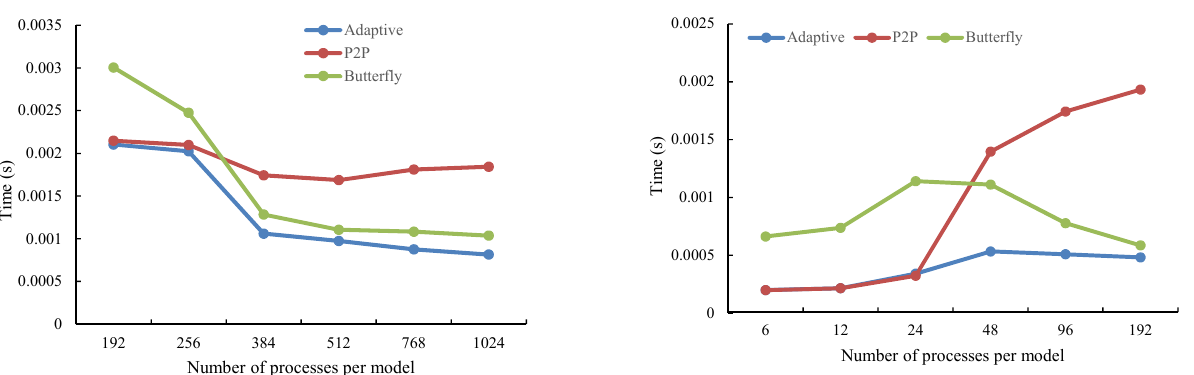
Figure 17. Average execution time ( y axis) of one data trans- fer between two toy models with the same rectangular grid (of 192 × 480 grid points) when varying the number of processes per model ( x axis). There are 10 2-D coupling fields transferred from the source toy model to the target toy model. In each test, the num- ber of MPI messages per sender process in the P2P implementation is 24.